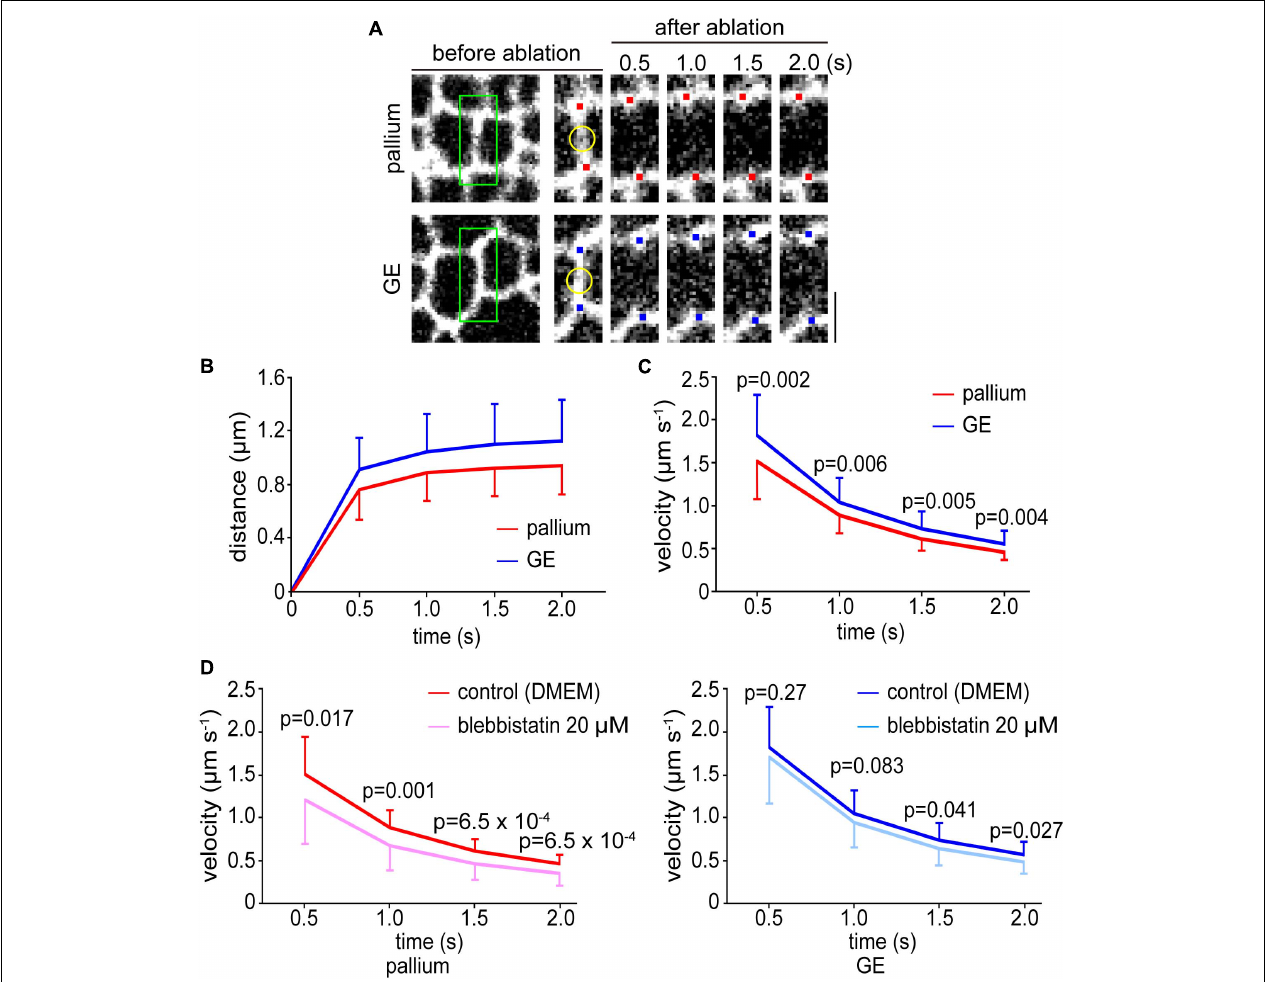
FIGURE 4 | Laser ablation experiments were performed on the apical surfaces of the pallium and the GE. (A) En face live images of the apical surfaces of the pallial and GE walls prepared from an E13 ZO1-EGFP transgenic mouse. Mesh-like patterns are shown by apices of NPCs. A short-pulse laser was applied to the midpoint (marked in yellow) on the enlarged images of a boundary line (enclosed in green) formed by two polygonal apices of neighboring EGFP-labeled NPCs. Red (pallium) or blue (GE) dots highlight the vertices tracked. Scale bar, 2 µ m. (B) Graph depicting the distance between the two tracked vertices at both ends of the laser-targeted side in pallium and GE. (C) Graph depicting the separation speed of two vertices at both ends of the laser-targeted side, showing that recoils were significantly quicker in GE ( n = 52 sides) than in pallium ( n = 35 sides) ( p = 0.002 at 0.5 s; p = 0.006 at 1.0 s; p = 0.005 at 1.5 s; p = 0.004 at 2.0 s, Mann–Whitney U -test). (D) Graph showing the results of laser ablation in the presence of blebbistatin. In the pallium (left), the separation speed was significantly slower ( n = 35 sides for control and n = 37 sides for blebbistatin) ( p = 0.017 at 0.5 s; p = 0.001 at 1.0 s; p = 6.5 × 10 − 4 , at 1.5 s; p = 6.5 × 10 − 4 at 2.0 s, Mann–Whitney U -test). In the GE (right), statistically significant differences were not observed at 0.5 s and 1.0 s ( n = 52 sides for control and n = 37 sides for blebbistatin) and smaller than in the pallium at other time points ( p = 0.27 at 0.5 s; p = 0.083 at 1.0 s; p = 0.041, at 1.5 s; p = 0.027 at 2.0 s, Mann–Whitney U